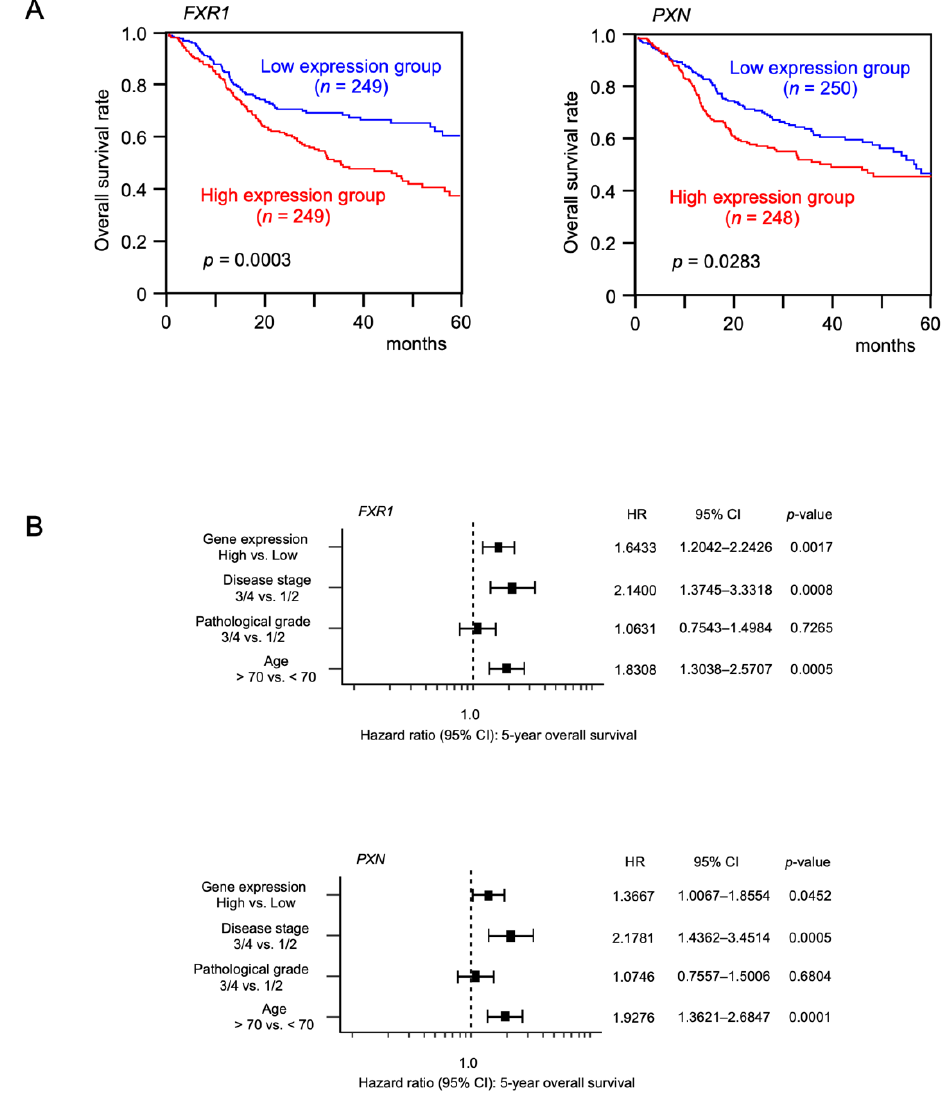
Figure 3. Clinical significance of FXR1 and PXN using TCGA-HNSC data. ( A ) Kaplan–Meier survival analyses of HNSC patients using data from TCGA database. Patients were divided into high and low expression groups according to the median FXR1 and PXN expression levels. The red and blue lines indicate the high and low expression groups, respectively. ( B ) Forest plot showing the multivariate analysis results for two genes (FXR1 and PXN), which were identified as independent prognostic factors for overall survival after adjustment for patient age, disease stage, and pathological grade.